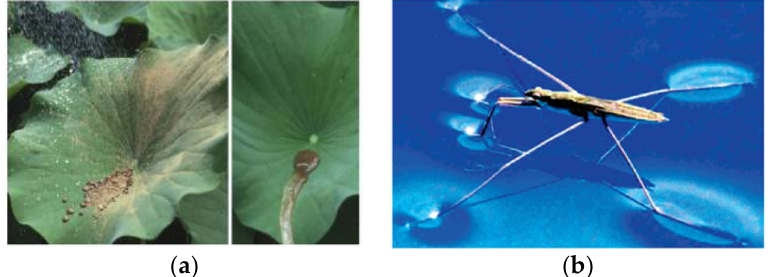
Figure 1. Droplet state on the surface.